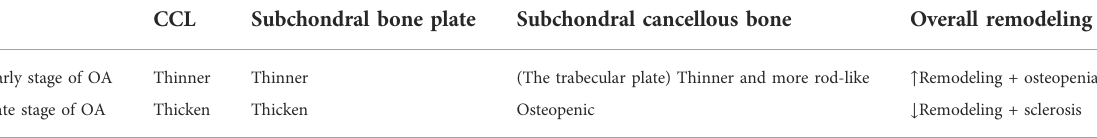
TABLE 1 CCL and subchondral bone changes during early and late stages of OA.